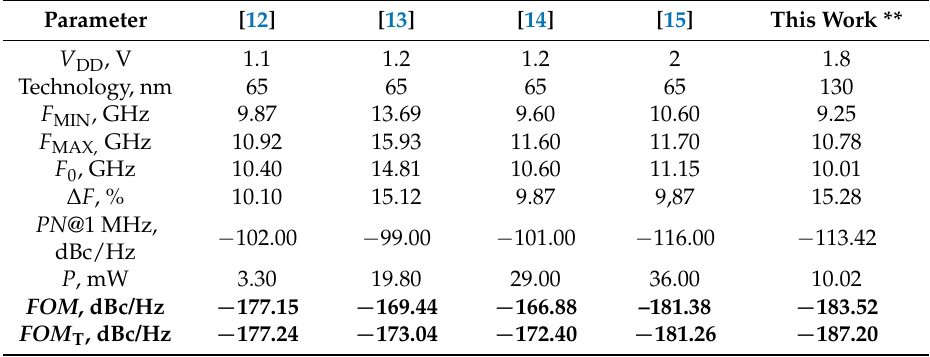
Table 2. Performance of the proposed LC DCO compared with other LC